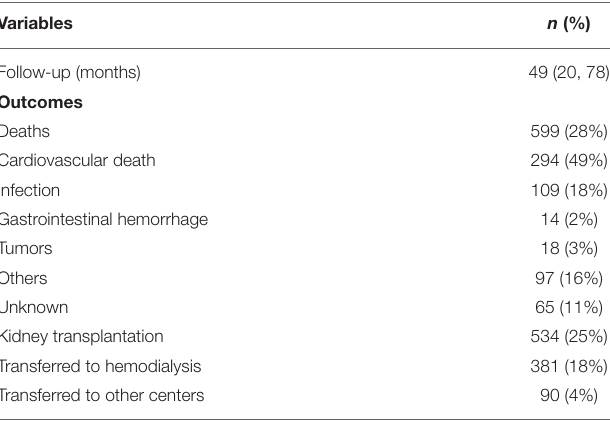
TABLE 2 | Outcomes of the study cohort.